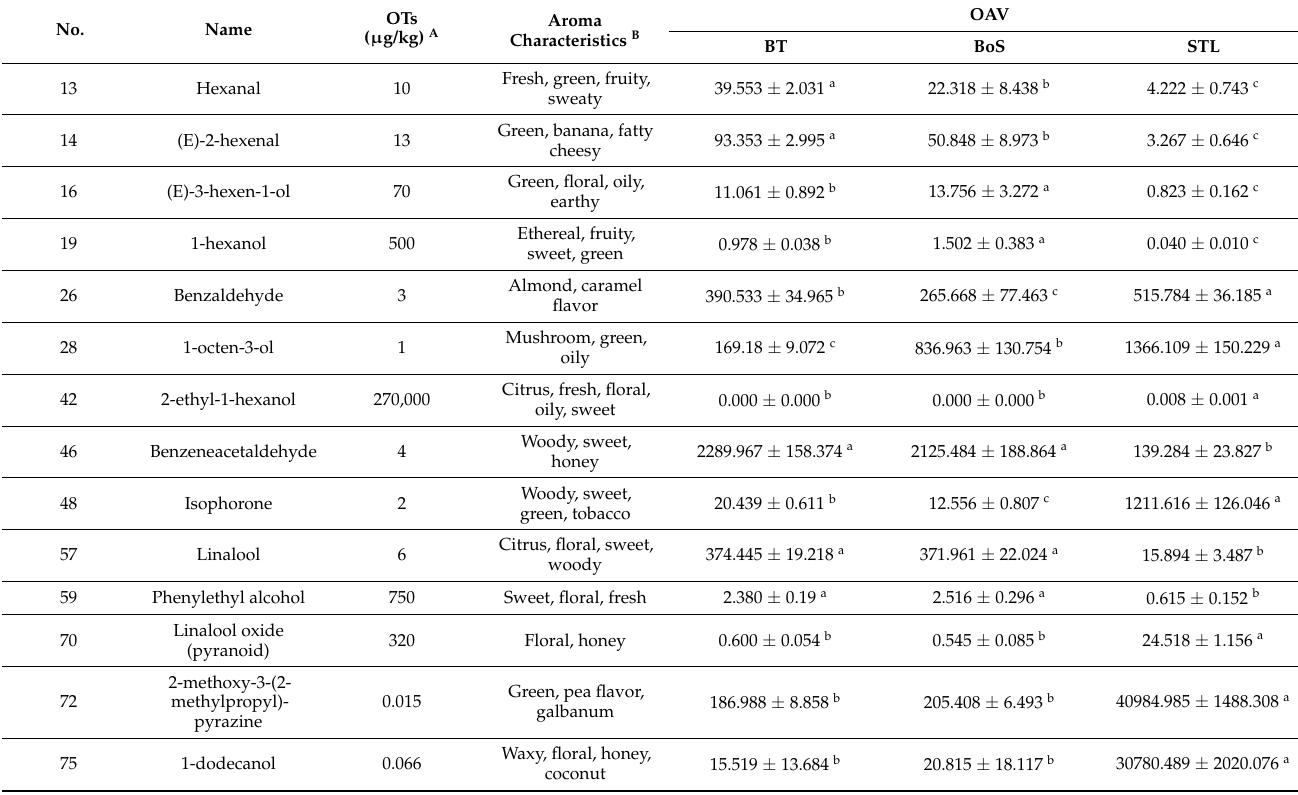
Table 3. Aroma characteristics and odor activity value (OAV) of key differential volatile metabolites in BT, BoS, and